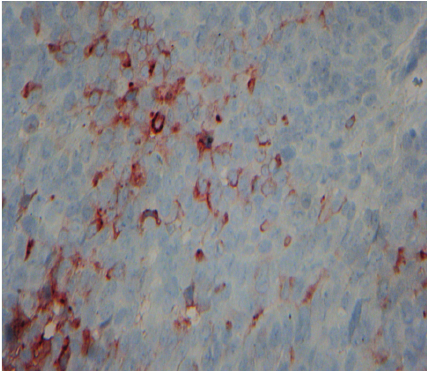
Figure 1: Large anastomosing ducts containing cell nests beneath ulcerated surface (hematoxylin-eosin staining, original magnifica- tion × 10).